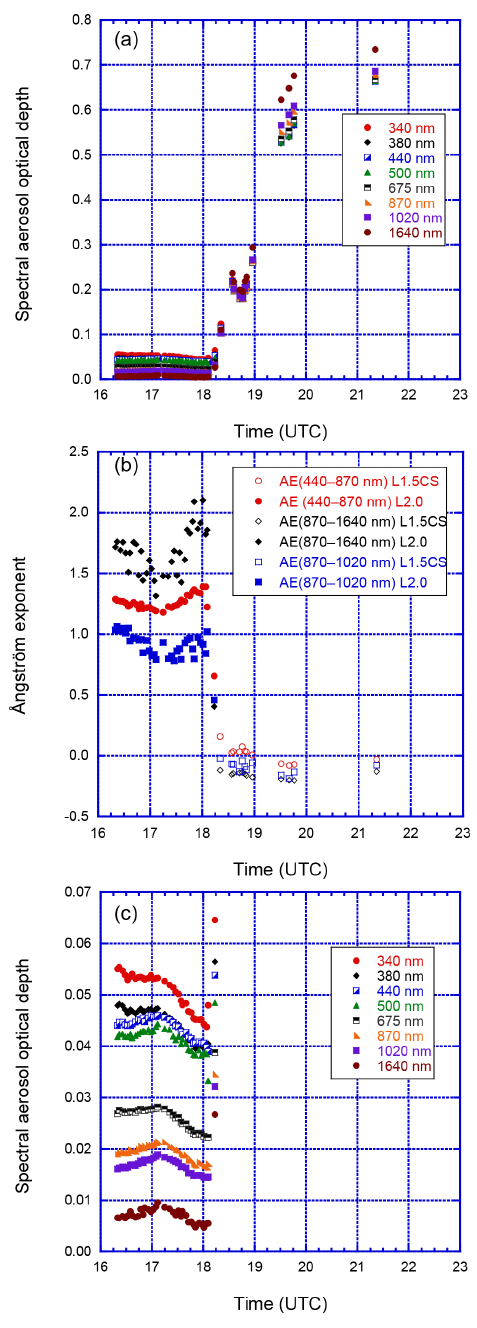
Figure 13. Data from Bratt’s Lake (lat 50.20, long − 104.71) on 7 January 2007. (a) The Level 1.5 data with only the cloud- screening (CS) algorithm applied show cloud-contaminated data remain after 18:10UTC. (b) For the same period as in (a) , the Ångström exponent values decreased significantly to a level at which coarse-mode aerosol particles are not expected. (c) The fi- nal Level 1.5 and Level 2.0 data series after the reverse spectral de- pendence quality control or additional cloud-screening method has been applied to the stand-alone Level 1.5 CS